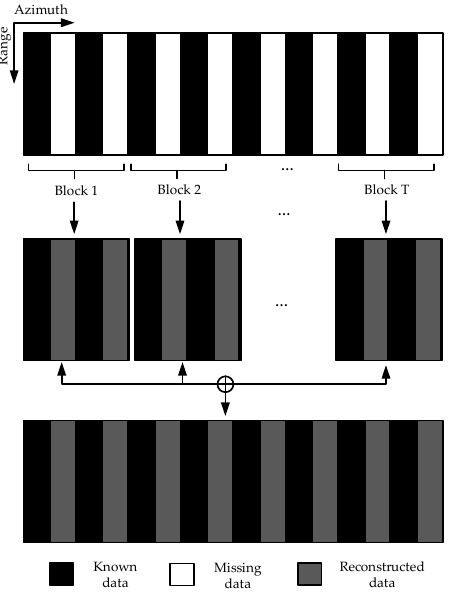
Figure 5. The schematic diagram of 2D echo matrix block restoration.